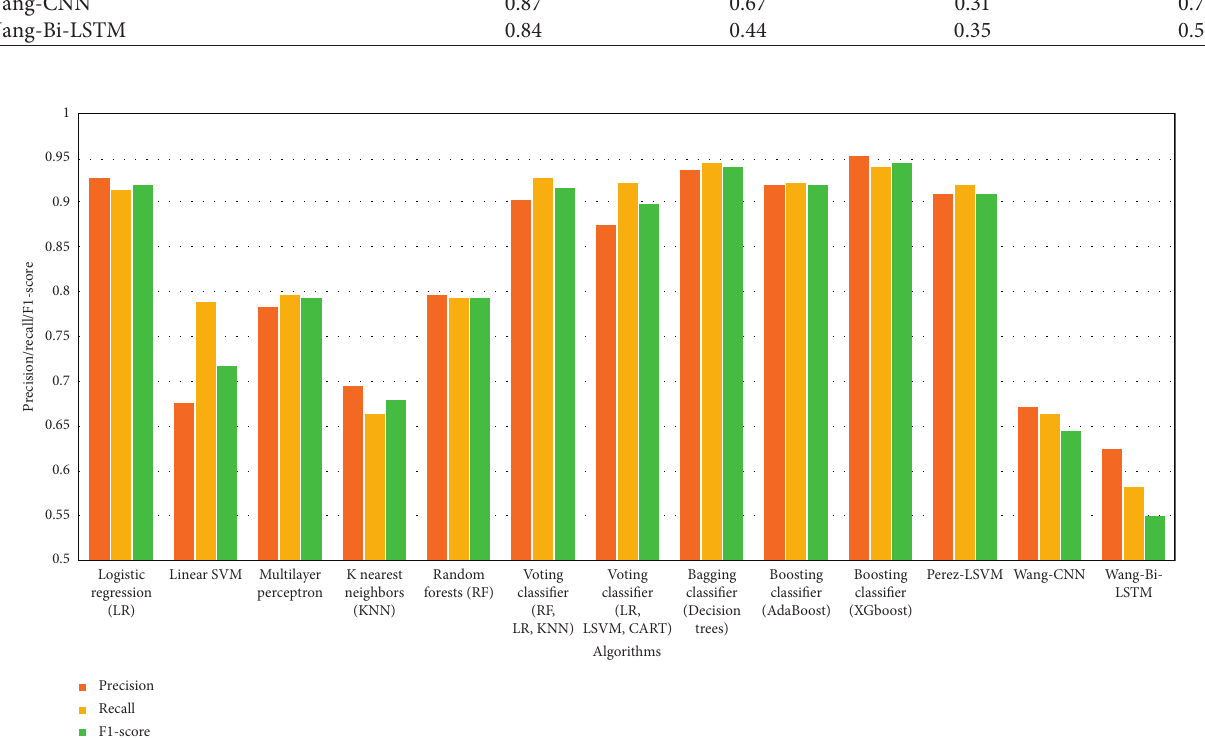
Figure 3: Precision, recall, and F1-score over all